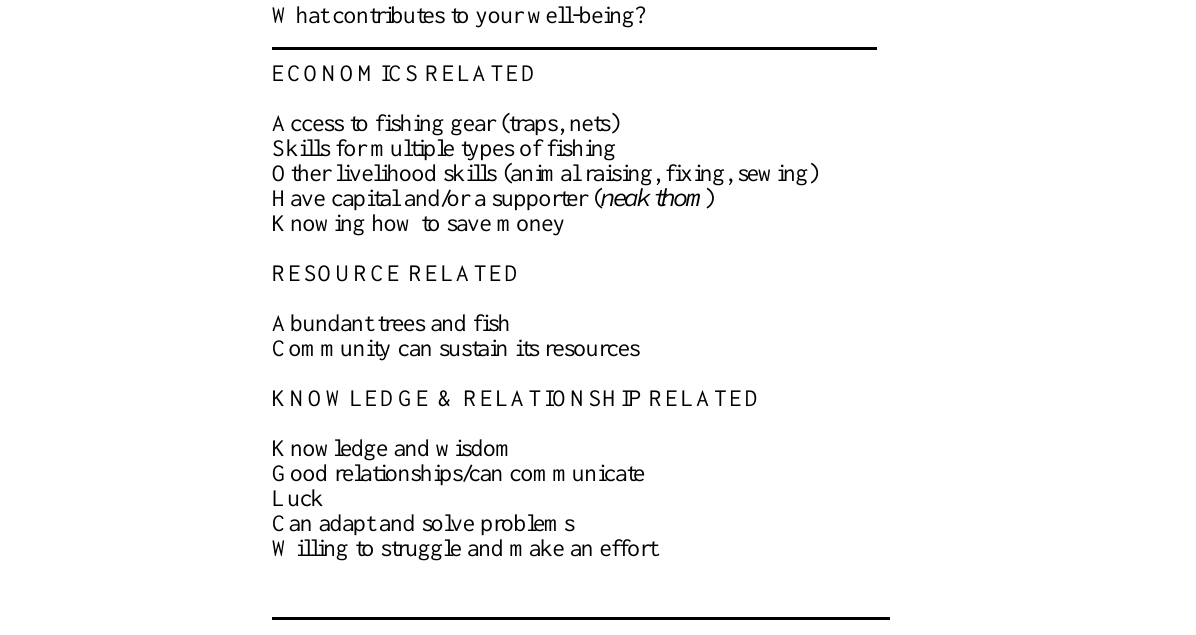
Table 3. Local aspects of